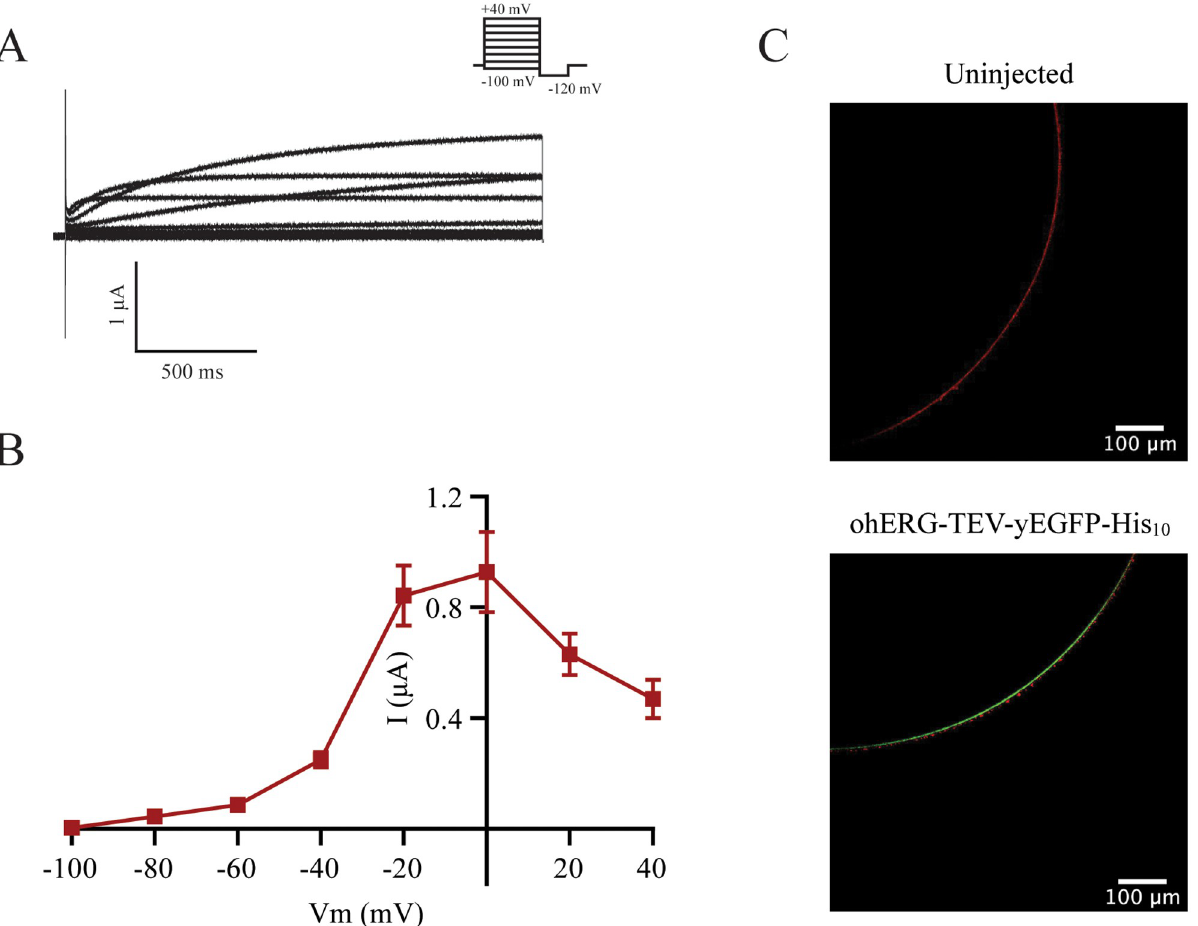
Fig 7. Expression of ohERG-TEV-yEGFP-His 10 in Xenopus laevis oocytes. (A) Representative current traces of ohERG-TEV-yEGFP-His 10 measured in Xenopus laevis oocytes as described in the materials and methods section 5 days after injection of 25 ng of polyA RNA in vitro transcribed from pXOOY. The tail currents recorded at -120 mV are shown in S5 Fig. (B) I-V relation of ohERG-TEV-yEGFP-His 10 given as the average ± S.E.M (n = 13). (C) Representative confocal images of oocytes incubated with FM 4–64. The upper image shows an uninjected oocyte, and the lower image shows an oocyte expressing ohERG-TEV-yEGFP-His 10 , which colocalized with FM4-64.